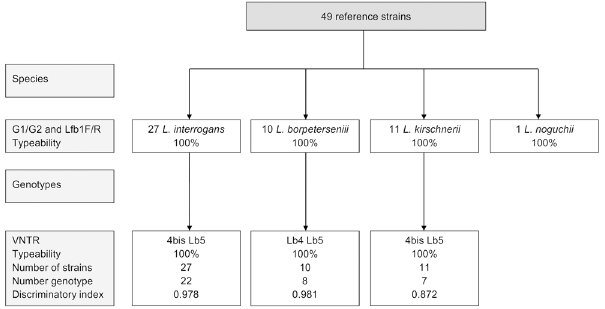
Fig 1. Determination of the Leptospira species and genotypes with reference